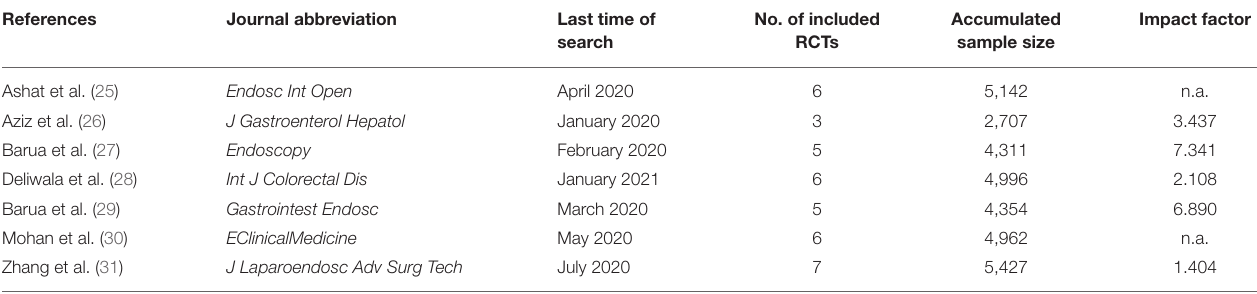
TABLE 1 | General description of the characteristics of each meta-analysis.